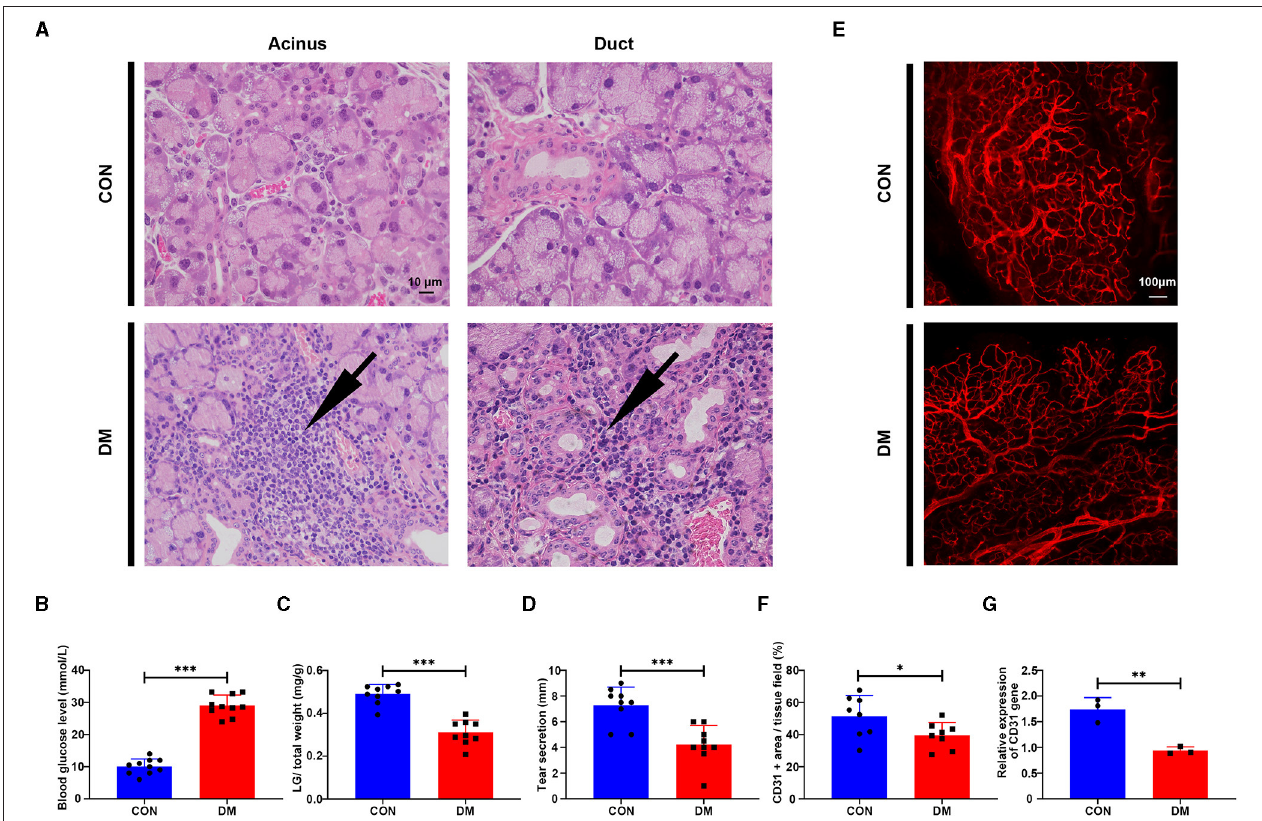
FIGURE 3 | Histological change of lacrimal gland from type 2 diabetic mice and vehicles. (A) Hematoxylin-eosin (HE) staining of LG from type 2 diabetic mice and vehicles after 6 months of high-fat diet (HFD) and the last-time streptozotocin (STZ) injection. Arrow denotes the inflammatory infiltration. N = 3/group. (B) Blood glucose level after 6 months of HFD and STZ injection. N = 10/group. (C) LG/total weight ratio after 6 months of HFD and STZ injection. N = 9/group. (D) Tear secretion volume after 6 months of HFD and STZ injection. N = 9/group. (E) Measurement of vascular distribution in the lacrimal gland in the vehicle and type 2 diabetic mice after 6 months of HFD and STZ injection by immunofluorescent staining of CD31. N = 3/group. (F) Quantification of CD31 + area/lacrimal tissue field ratio from diabetic mice and vehicles. N = 8 fields/group. (G) Relative gene expression of CD31 in the lacrimal gland from diabetic mice and vehicles by PCR. N = 3/group. * P < 0.05, ** P < 0.01, *** P <